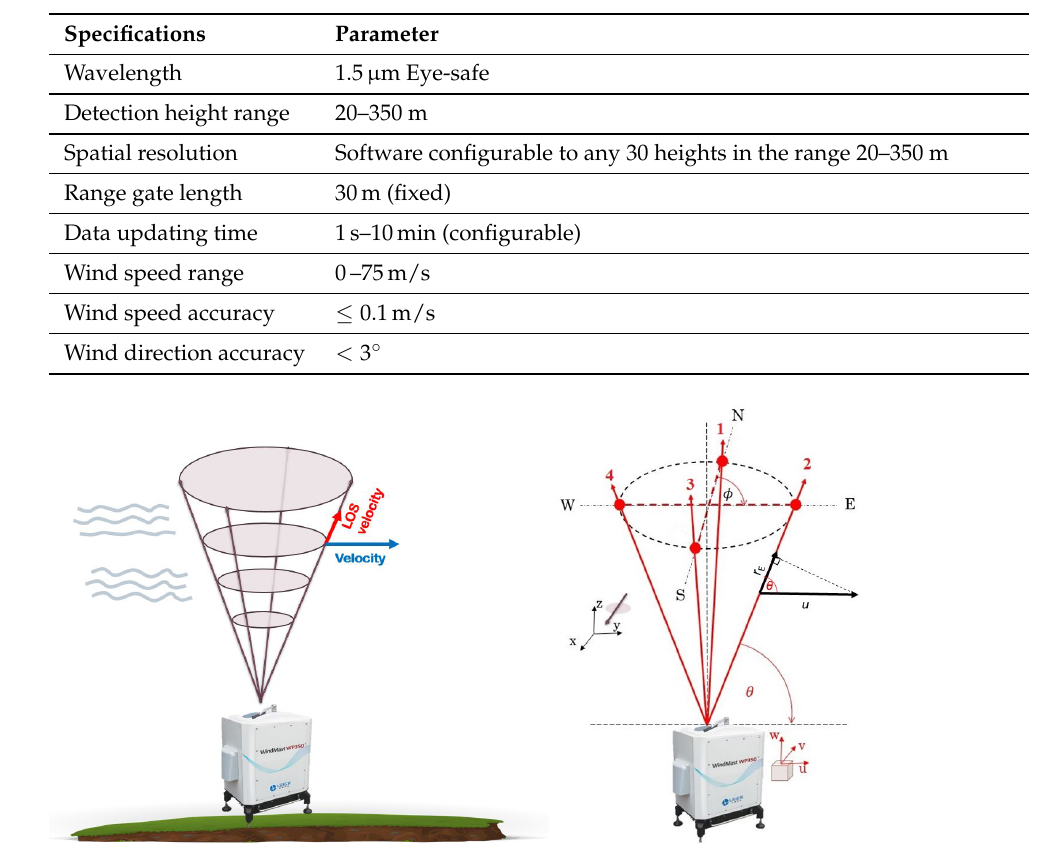
Table 1. Technical specifications of the Leice Doppler wind lidar WindMast WP350 [19].